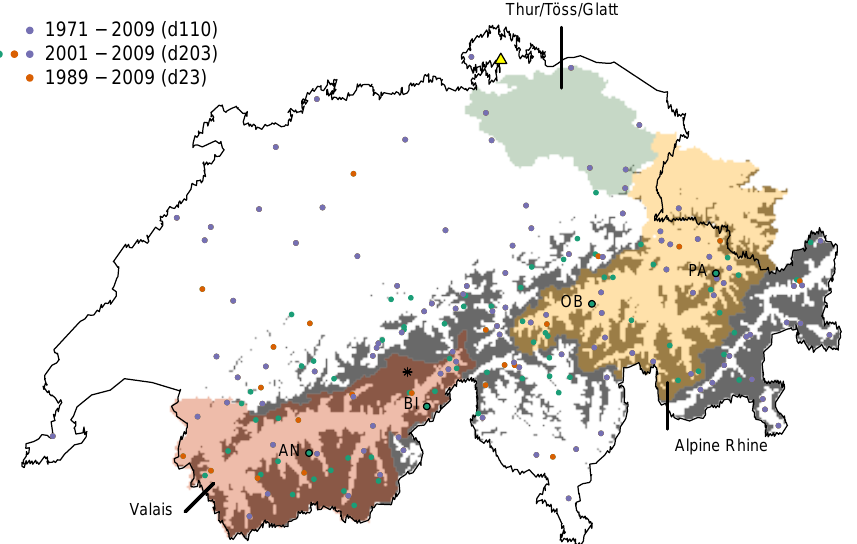
Fig. 1. Stations available during the different time periods: 110 stations from 1971 to 2009 (d110, purple dots), 203 stations from 2001 to 2009 (d203, purple, orange and green dots) and 23 stations from 1989 to 2009 (d23, orange dots). The three sub-areas – Alpine Rhine, Valais and the region including the rivers Thur, Töss and Glatt – are considered in this study. Areas shaded grey are higher than 2000ma.s.l. The four labelled stations with black outlines are used for validation. The yellow triangle is the river gauge in Neuhausen. The black star is a grid cell chosen for illustration in Sect. 4.3.